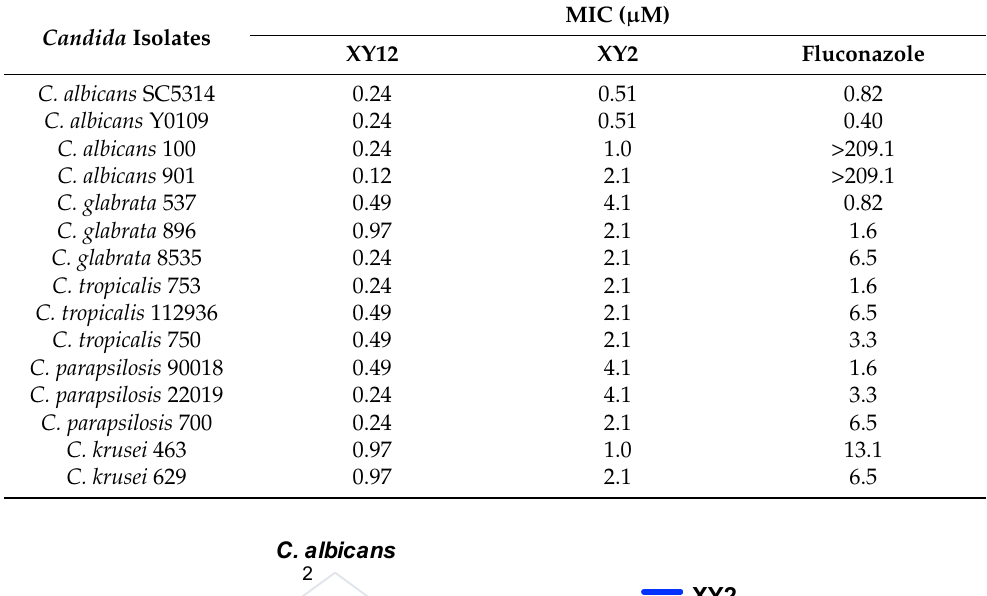
Table 2. Antifungal activity of XY14 against Candida .